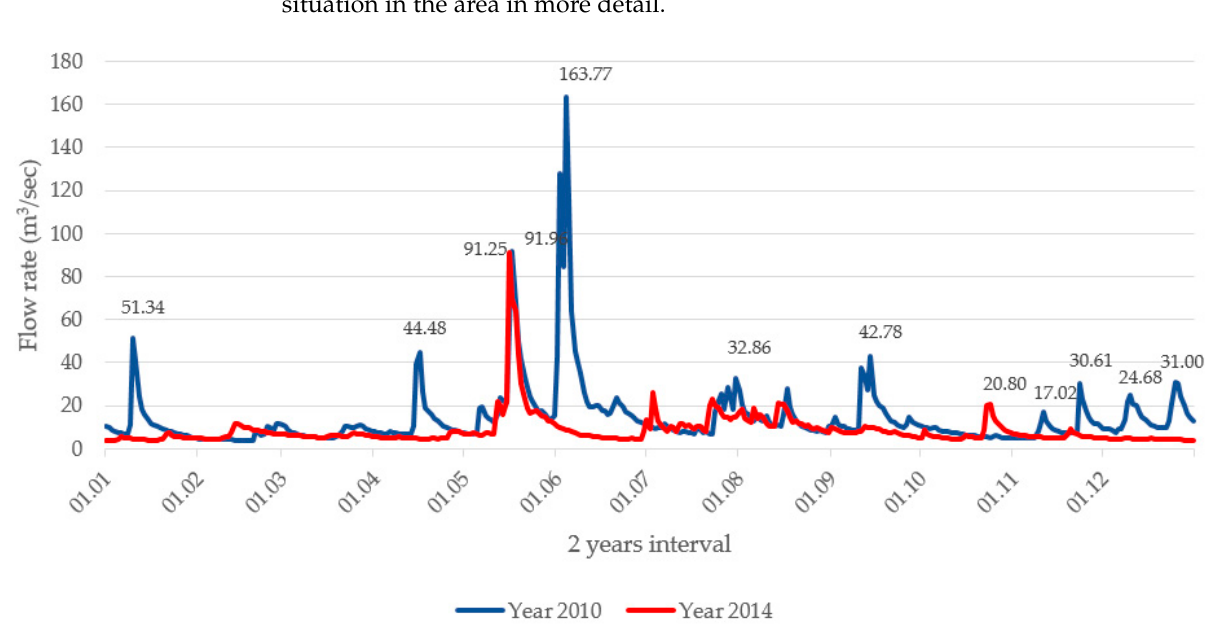
Land 2023 , 12 , x FOR PEER REVIEW Figure 2. Average monthly flow rate (m 3 /s) in 2010 and 2014. Figure 2. Average monthly flow rate (m 3 /s) in 2010 and 2014.